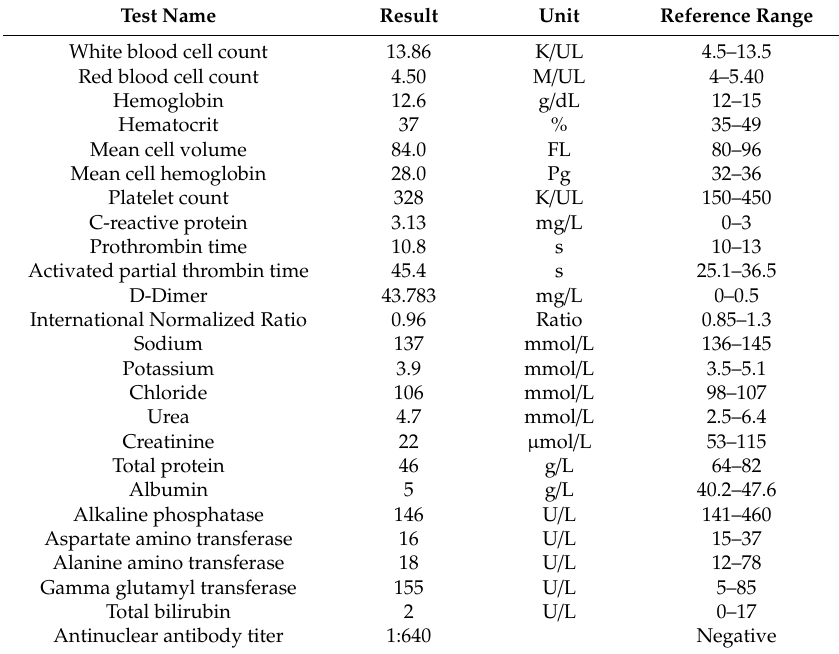
Table 1. Laboratory results at the time of